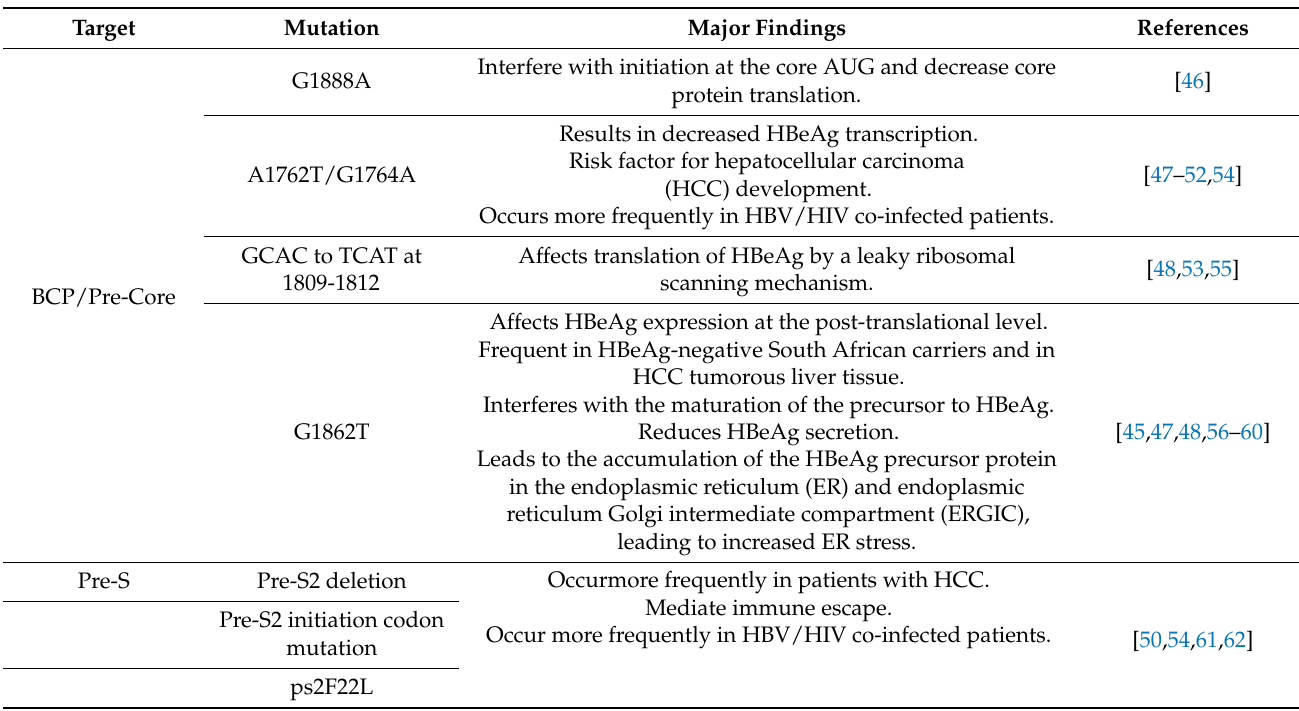
Table 1. Molecular and functional characterization of HBV subgenotype A1